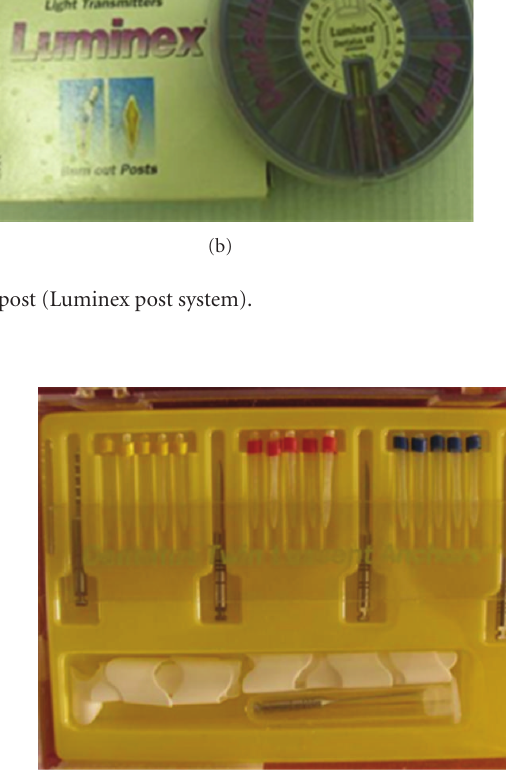
Figure 3: Luscent Anchor